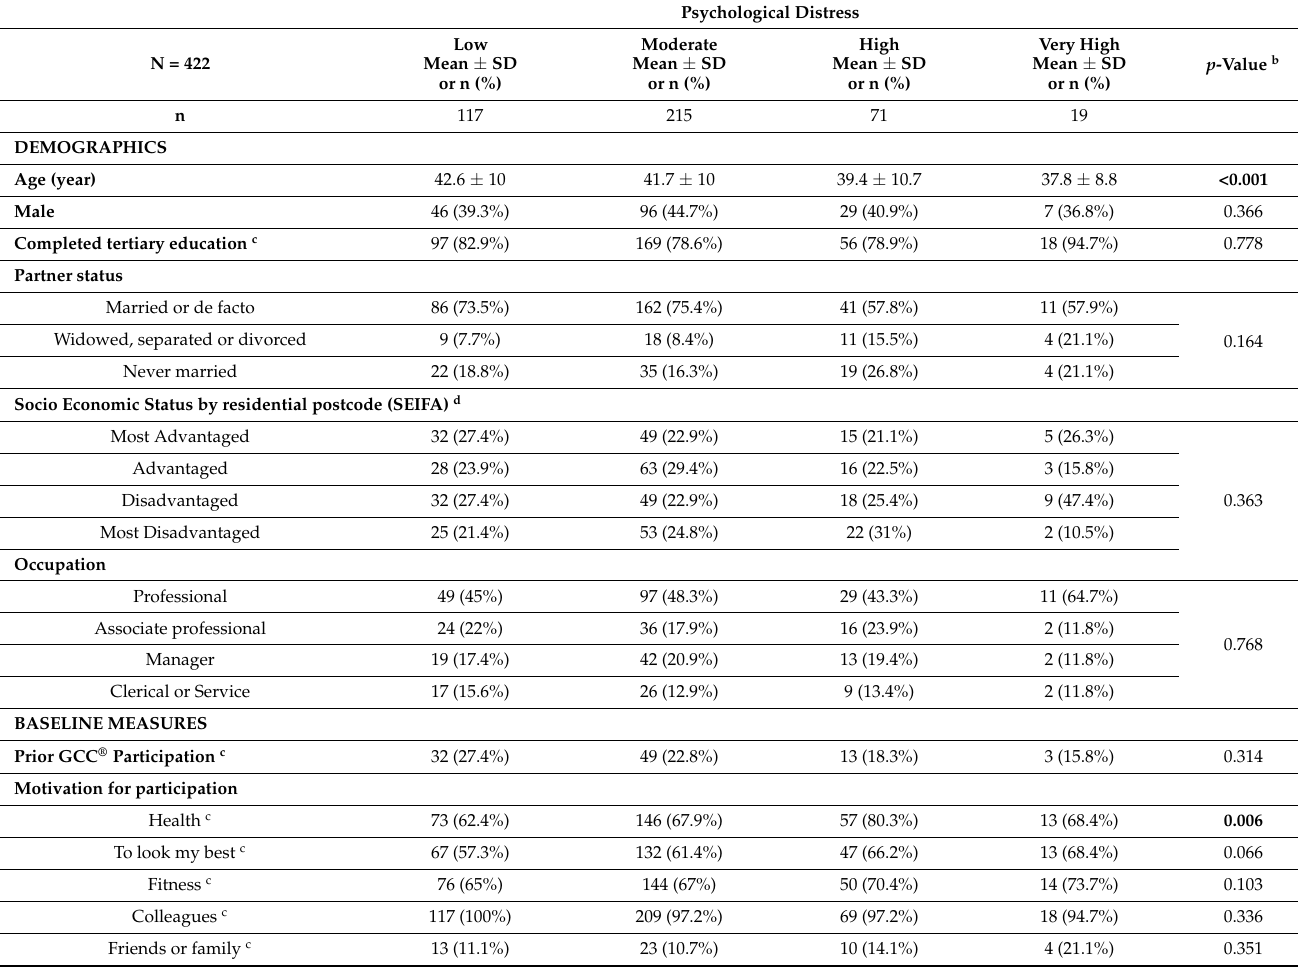
Table 1. Baseline characteristics of participants with low, moderate, high and very high levels of psychological distress (K10 scores), n = 422 a